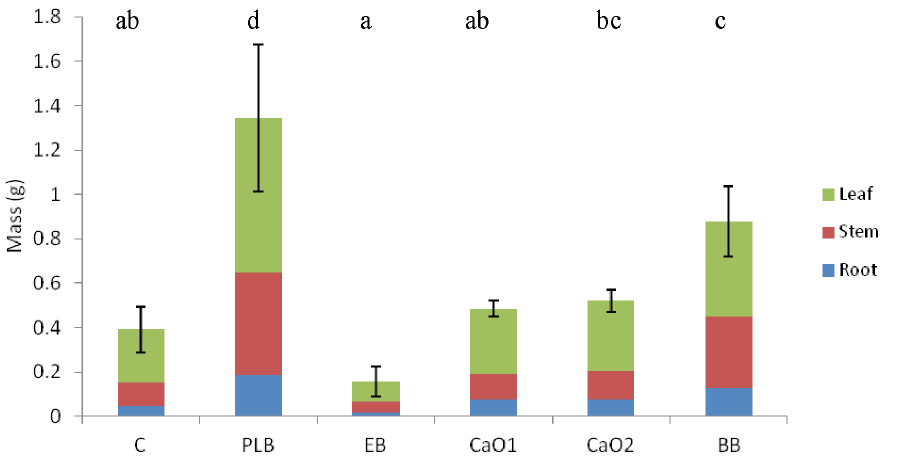
Figure 3. Total plant biomass at the end of the experiment. Different letters in the same indicate statistical significant differences for the factor ‘‘type of amendment’’ (P , 0.05).